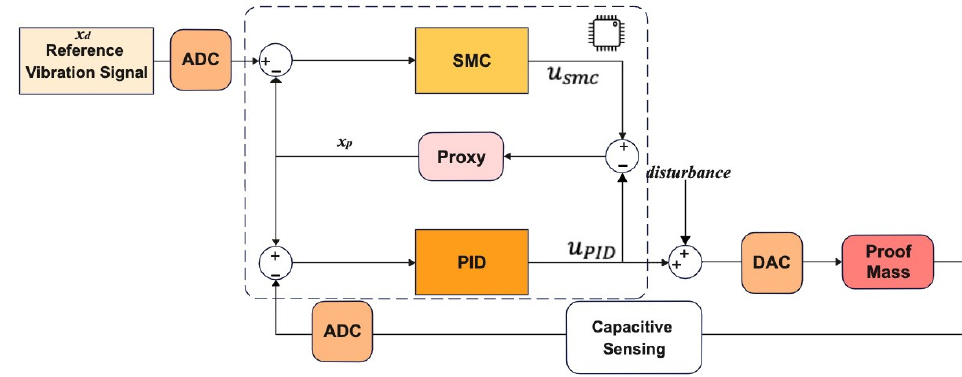
Figure 5. PBSMC (Proxy-Based Sliding Mode Controller) Working Principle.